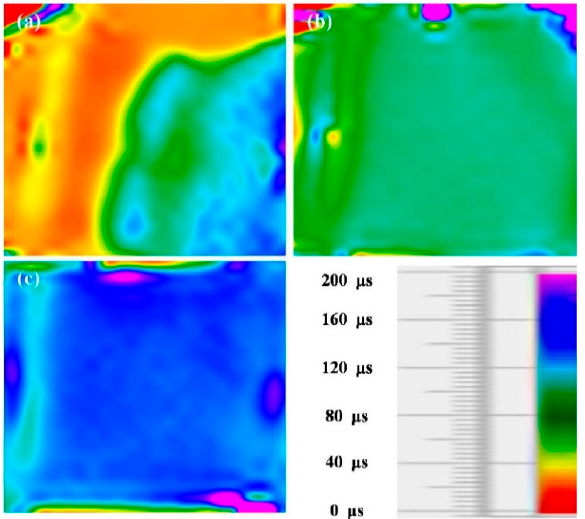
Figure 4. Minority carrier lifetime (at 1 sun injection level) images of ( a ) silicon nanotextured wafer coated with 80 nm SiN X , ( b ) silicon nanotextured wafer coated with 100 nm Al 2 O 3 , and ( c ) silicon blank wafer coated with 80 nm SiN X .